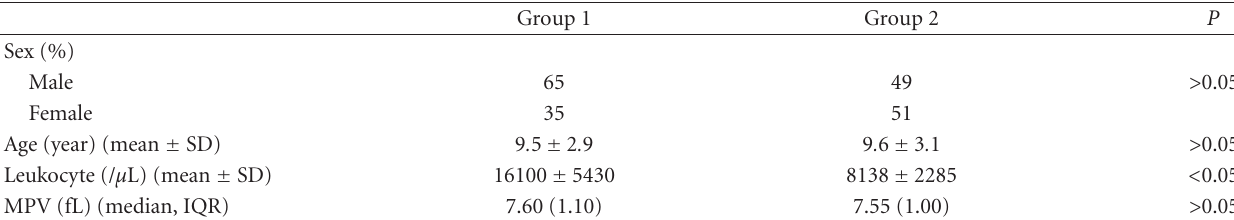
Table 2: Demographics and laboratory findings of